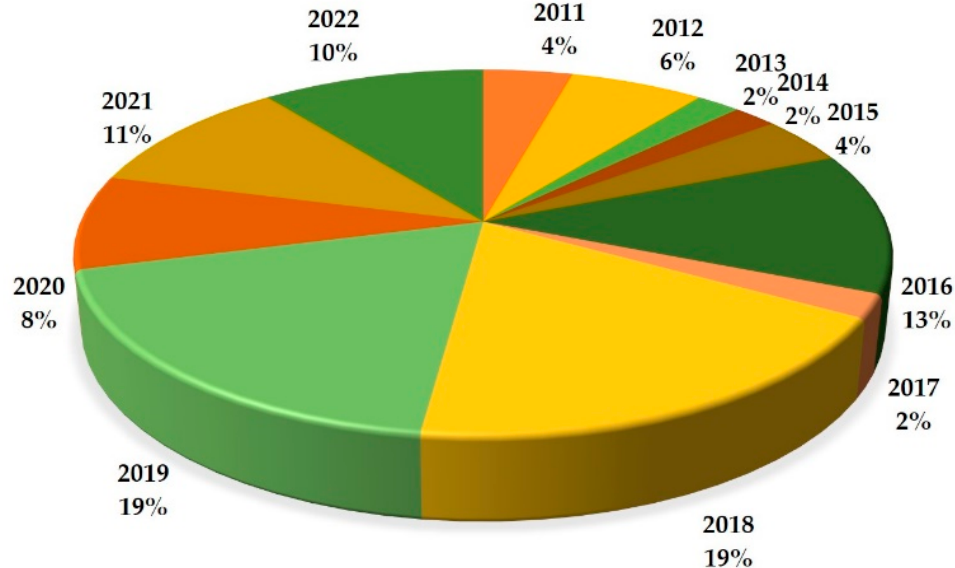
Figure 3. Distribution of studies in terms of their year of publication (2011–2022).